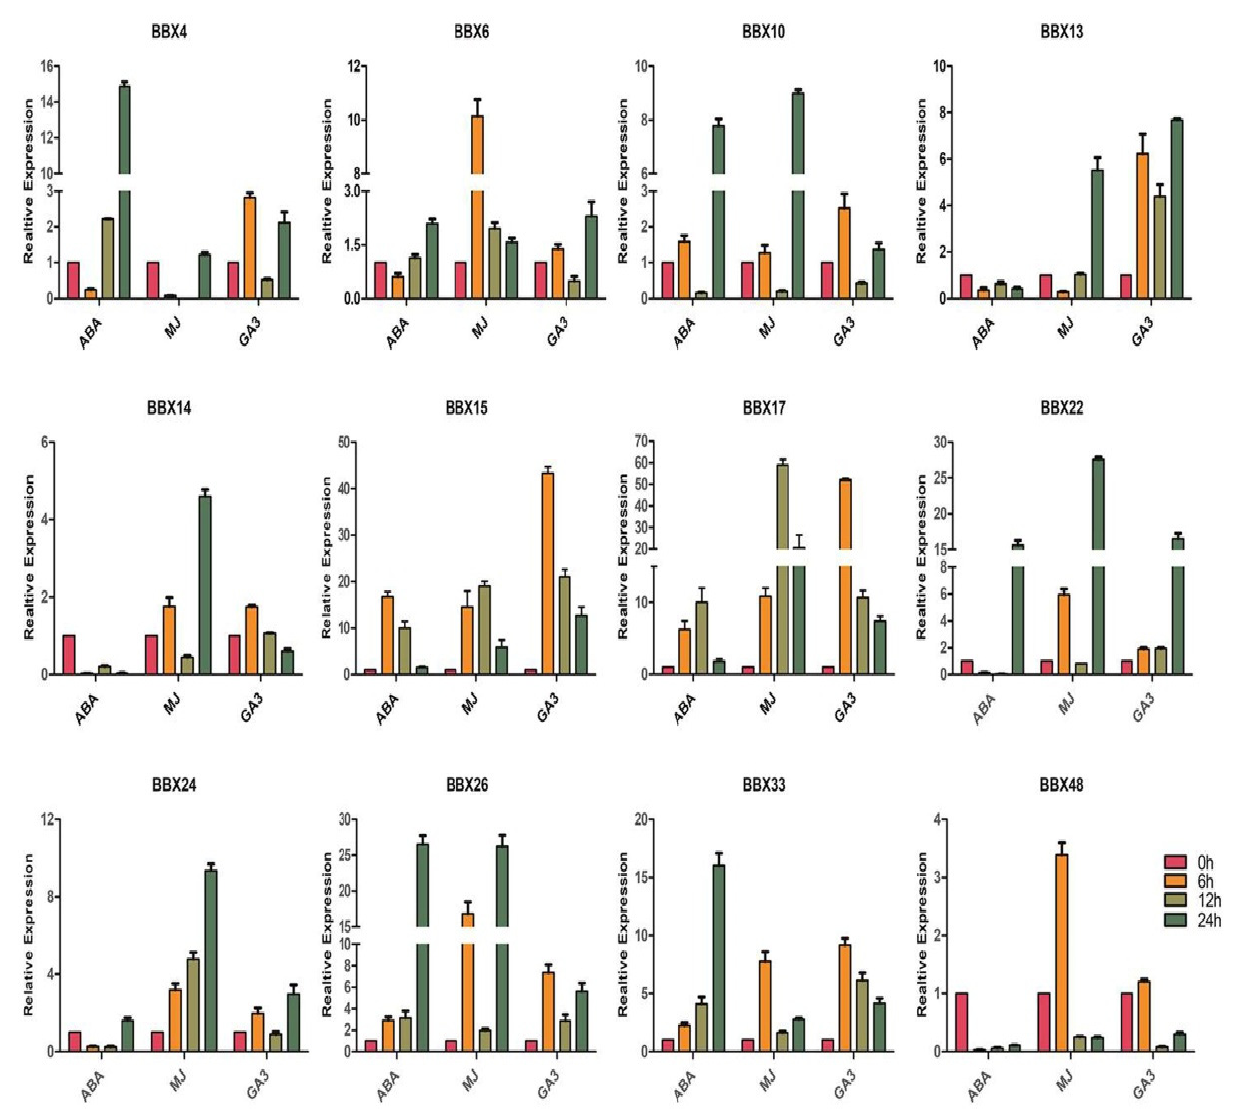
Figure 12. Inducible expression profiles of Brassica BBX genes in response to exogenously applied hormones. The x -axis presents the treatments. The y -axis presents the expression levels relative to the expression at the 0-h time point. Error bars indicate the standard deviations of three independent qRT-PCR biological replicates.